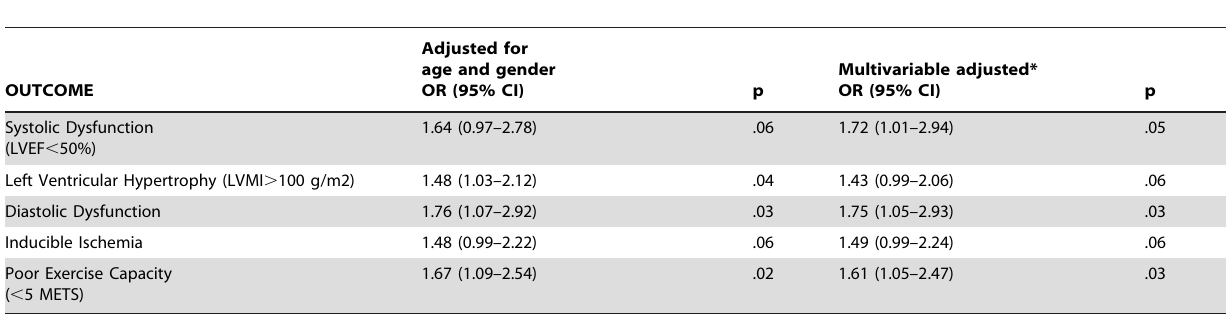
Table 4. Association of CC (vs. GG or CG) genotype at rs2296545 with dichotomous measures of cardiovascular structure and